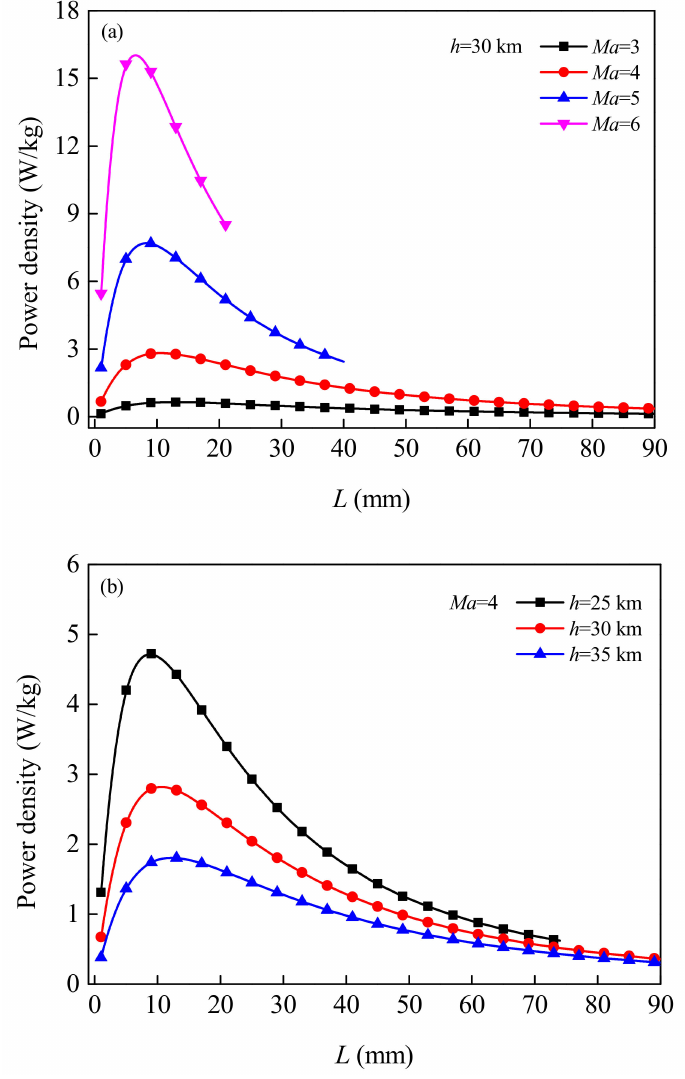
Figure 8. Variation of output power density of TEGs changing with the length of the TE leg under different flight Mach Numbers ( a ) and flight altitudes ( b